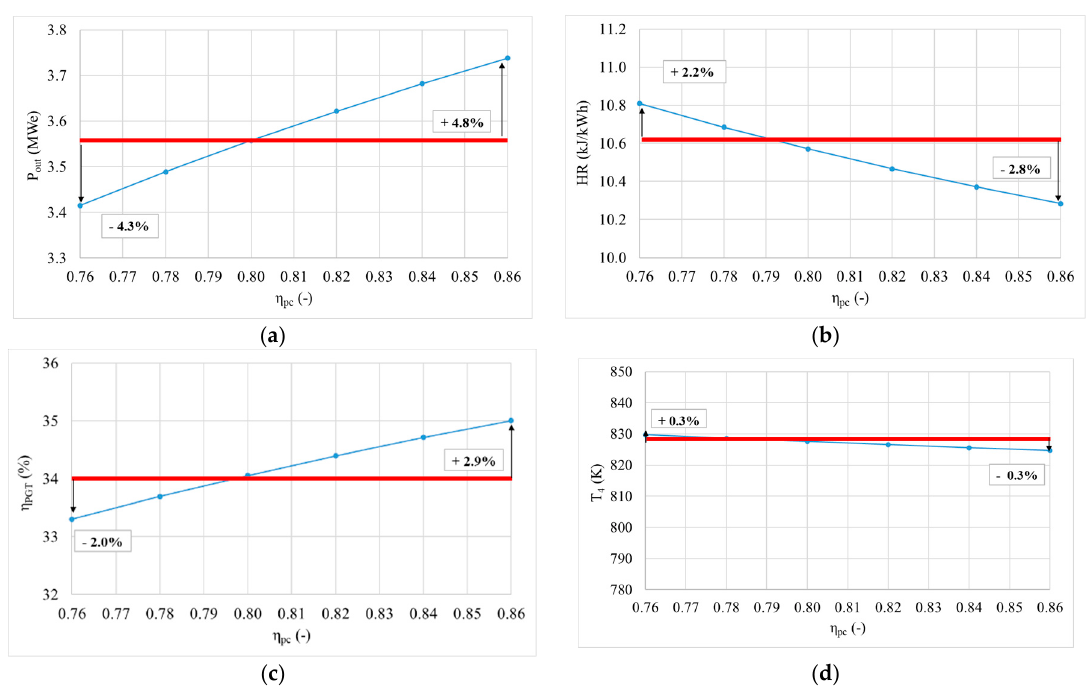
Figure 7. Change of gas turbine cycle outlet parameters in function of compressor polytropic efficiency ( a ) power change in function of compressor polytropic efficiency, ( b ) heat rate change in function of compressor polytropic efficiency, ( c ) gas turbine plant efficiency change in function of compressor polytropic efficiency and ( d ) change of temperature of the expanded products at the gas turbine outlet in function of compressor polytropic efficiency.